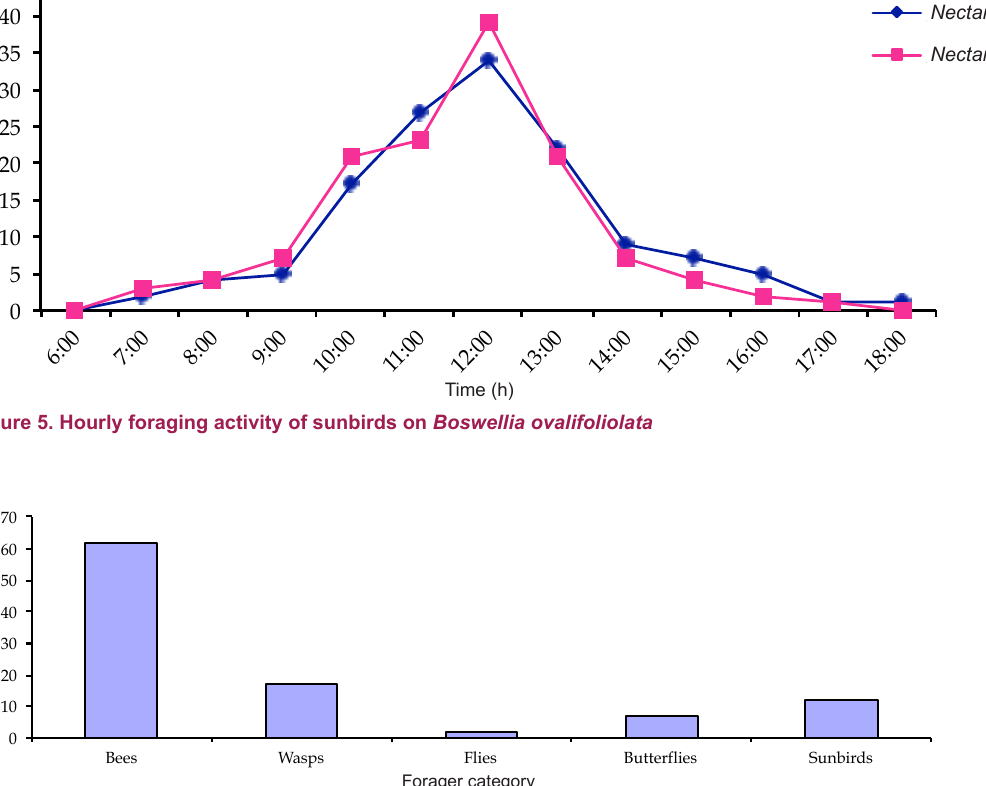
Figure 6. Relative percentage of foraging visits of different categories of insects and sunbirds on Boswellia ovalifoliolata